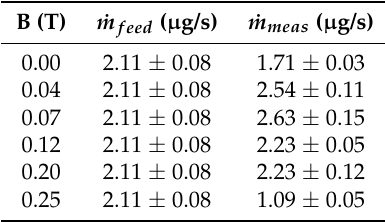
Table 2. Comparison between cathode average mass flow consumption, calculated from active feeding and direct measurement. B (T)